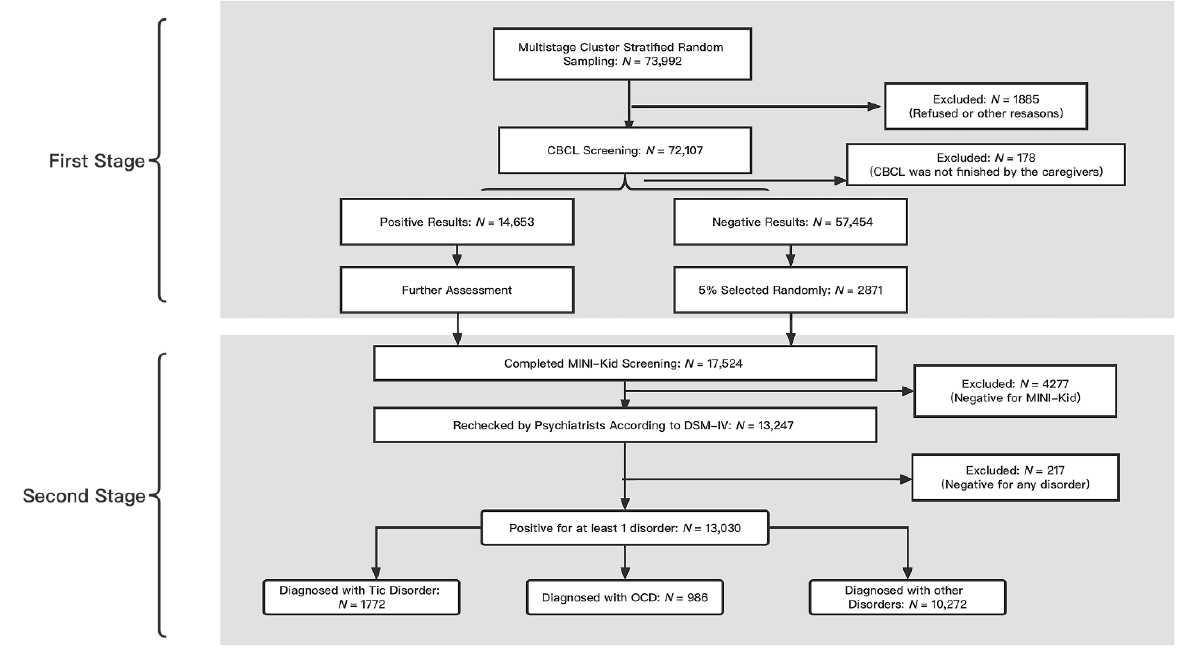
Figure 1. The flowchart for the procedures of this national survey of OCD and TDs (CBCL: Child Behavior Checklist; MINI-Kid: Mini International Neuropsychiatric Interview for Children and Adolescents; OCD: obsessive-compulsive disorder).